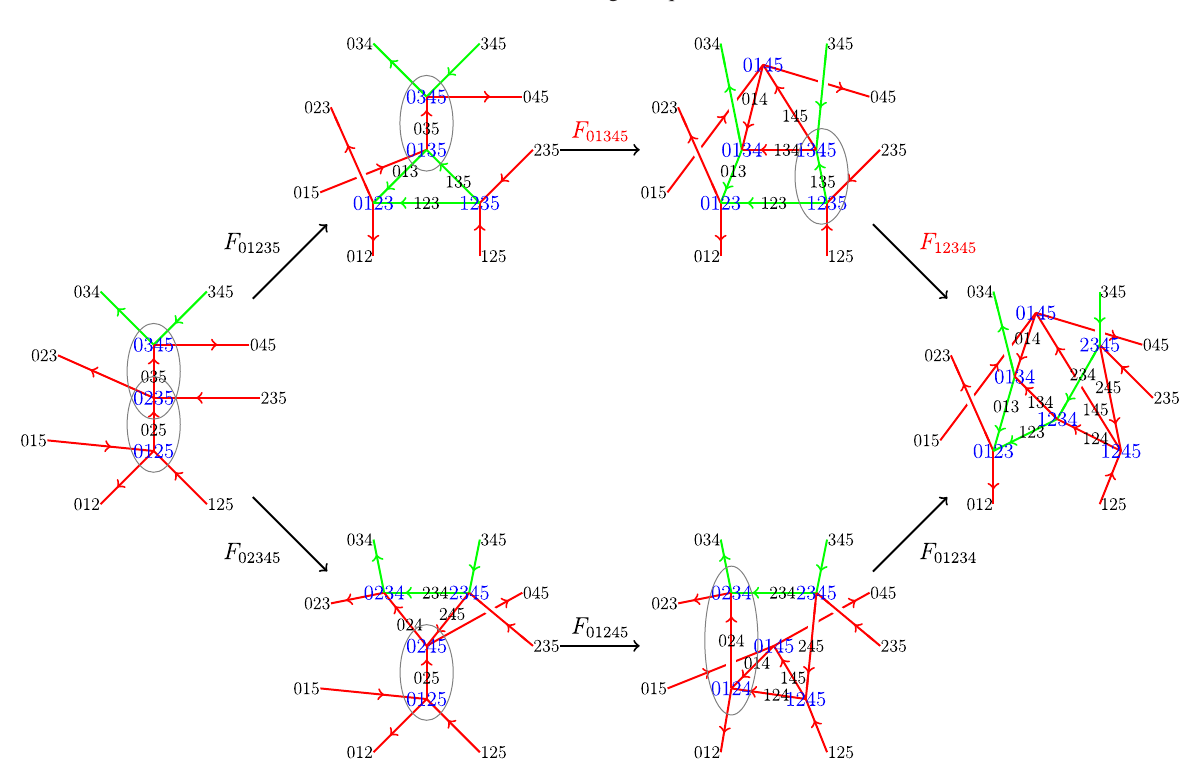
.FIG. 21. Fermionic fusion hexagon equation on dual lattice P